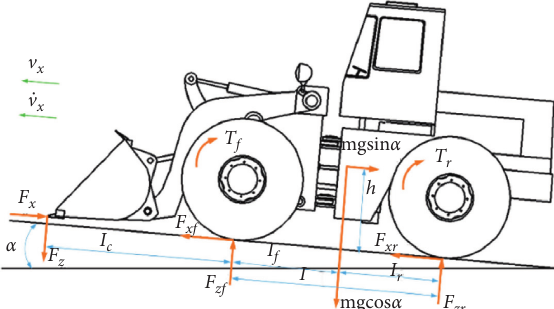
Figure 3: Longitudinal dynamic model of